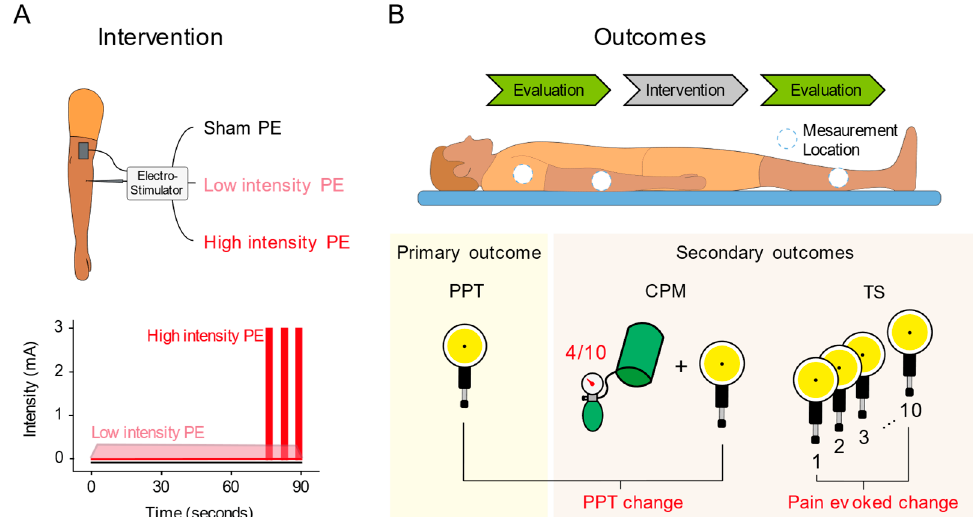
Figure 2. Study methodology illustration. ( A ) The needle intervention, the three PE protocols appli ‐ cation, and the representation of the intensity variation through the intervention duration depend ‐ ing of the PE group. ( B ) The outcomes assessment timeline, location, and methodology applied. PPT, Pressure Pain Threshold; CPM, Conditioned Pain Modulation; and TS, Temporal